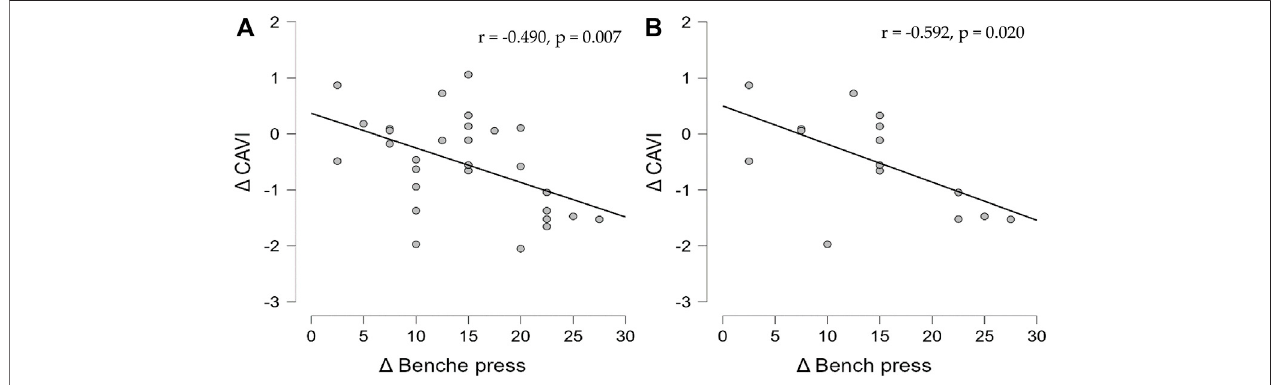
FIGURE2| AssociationbetweendeltavalueinCAVIand deltavalueinbench press. (A) Inallparticipants,thedecreaseinCAVIwassigni fi cantnegativecorrelation with the increase in 1RM bench press. (B) In TRT group, the decrease in CAVI was also signi fi cantly negative correlated with the increase in 1RM bench